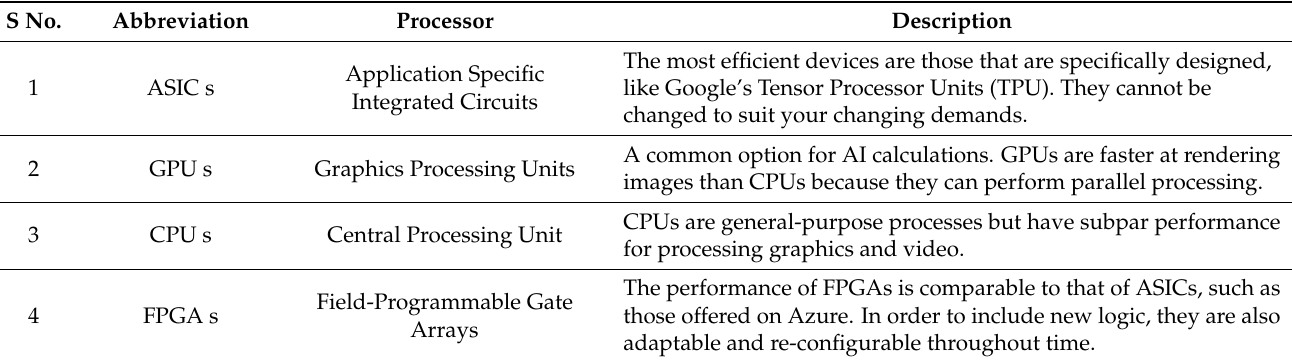
Table 1. Performance description of